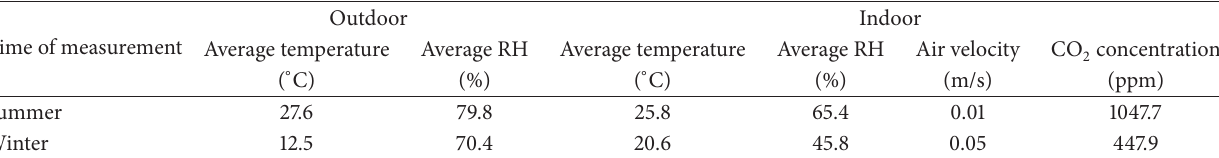
Table 1: Measured results for the indoor and outdoor physical parameters of the